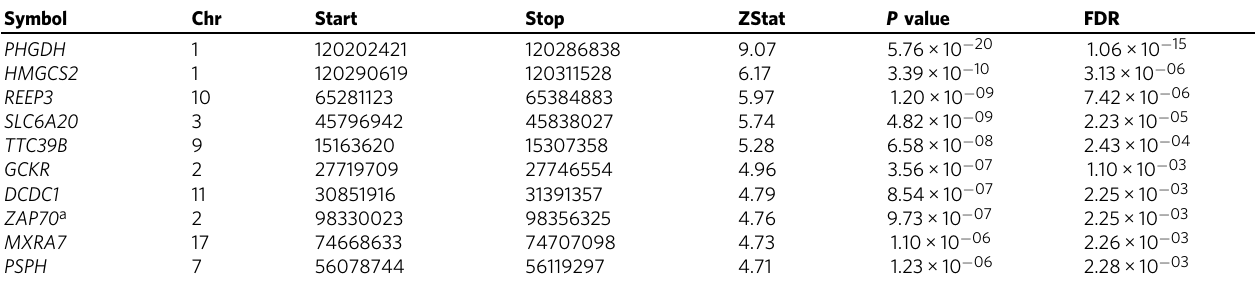
Table 3 Top ten genes enriched with SNPs signals (MAGMA). Symbol Chr